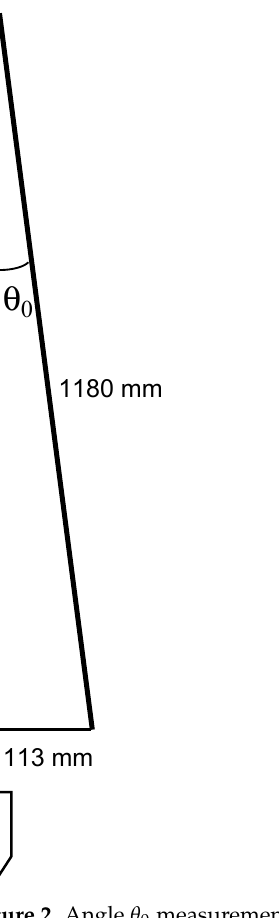
θ Figure 2. Angle 0 measurement scheme. Figure 2. Angle θ 0 measurement